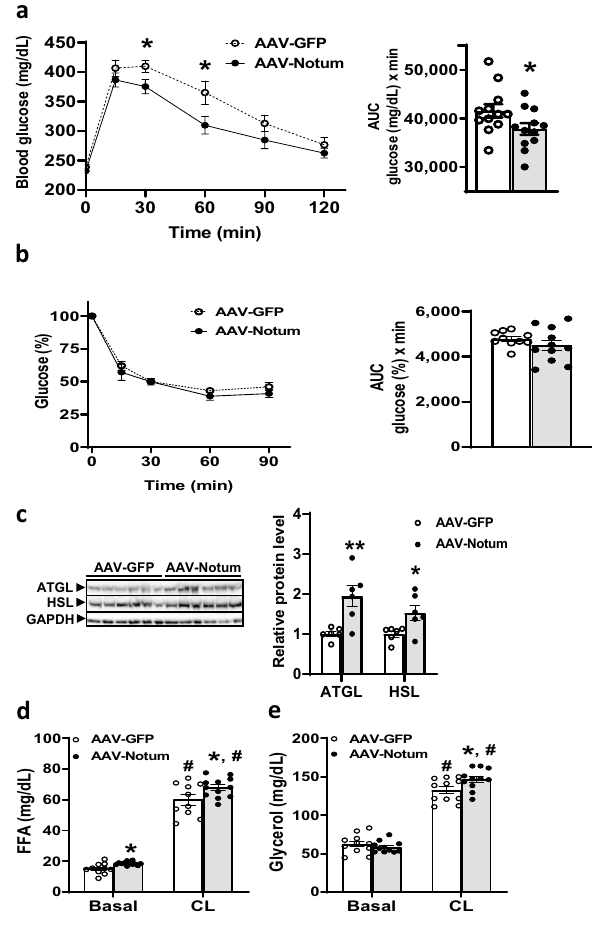
Figure 3. NOTUM overexpression improves glucose tolerance and increases lipolysis capacity. AAV-GFP and AAV-Notum infected mice (n = 11 to 12 mice per group) were maintained on a HF/HS diet for 10 to 12 weeks before the following experiments were performed. ( a ) IPGTT was performed as described in “Material and methods” section. Blood glucose levels, right, and glucose AUC, left, are shown. ( b ) ITT was performed as described in “Material and methods”. Blood glucose levels, left, and glucose AUC, right, are shown. ( c ) ATGL and HSL protein levels in iWAT were determined by immunoblotting (n = 6 per group), left. Relative protein levels of ATGL and HSL, as normalized by GAPDH levels, were shown in right. Images of ATGL, HSL, and GAPDH were obtained from different parts of the same blot. ( d , e ) β3 adrenergic receptor agonist stimulated lipolysis was performed as described in “Material and methods” section. Plasma free fatty acid (FFA, d ) and glycerol ( e ) levels at time 0 (basal) and 30 min after injection of CL316,243 (CL) are shown (n = 10–12 per group). Symbols: *: p < 0.05, **: p < 0.01, AAV-GFP versus AAV-Notum as determined by Student’s t-test. For ( c ) and ( d ), #: p < 0.05 versus time 0 (basal) of the same AAV